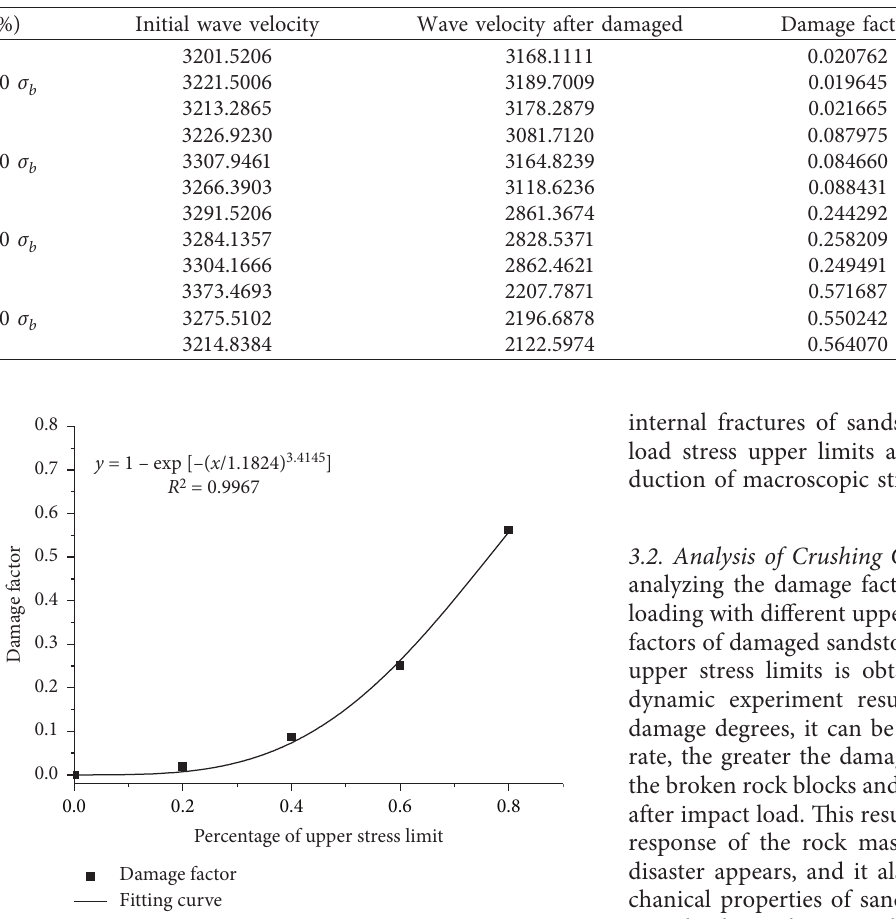
Table 1: Wave velocity change table before and after sandstone is subjected to cyclic loading.